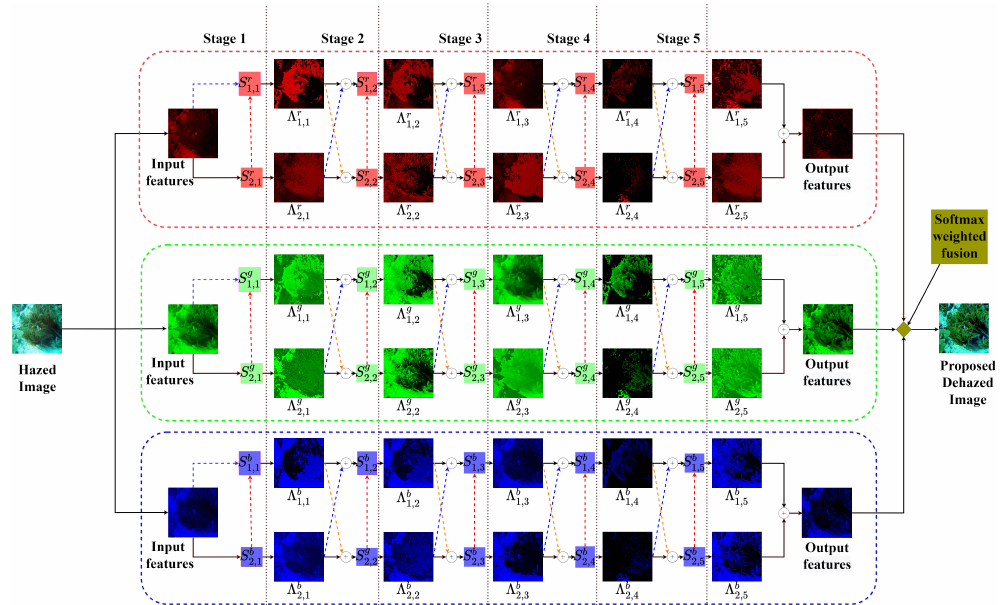
Figure 4. A detailed illustration of the dual-path block and the parallel interaction function. Within the dual-path block, the top sequential units constitute a branch Path Λ c , and the bottom units constitute 1 the other branch Path Λ c . These two paths interact with feature maps through the parallel interaction 2 function (four red-colored dotted lines) until the final stage. The image reconstruction block is used to reconstruct the corresponding color channel’s dehazed images. The color channels are then fused via a softmax-weighted stack to obtain the dehazed image. At each stage, units S c i , j ∀ i = { 1,2 } , j = { 1, . . . 5 } of a ConvLSTM block and a pixel-wise convolution take features from the parallel interaction function and previous units as inputs.